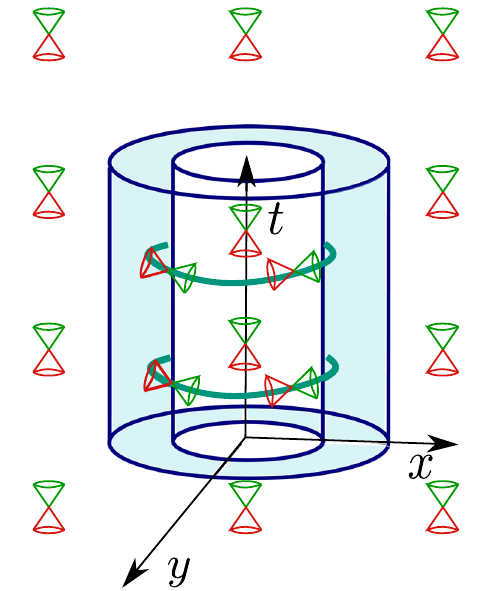
Fig. 6 We represent here the geometries described in the text. The different cases, corresponding essentially to the finite, the semi-infinite and the infinite cylinder display this same structure, with the difference relying on whether the cylinder is confined to lie within a compact interval [ t a , t b ] , a semi-infinite interval [ t C , ∞ ) or the whole real line ( −∞ , ∞ ) . The grey-shaded region lying within the inner and outer surfaces of the cylinder is the region where the angular coordinate φ becomes timelike, since the lightcones tilt enough for orbits of φ to be timelike curves. Outside the shaded region this abnormal behaviour of the ligthcones disappears and they are simply (or approximately as we have discussed in the text) flat spacetime lightcones. It must be noticed the difference between this higher dimensional case and the two-dimensional case discussed above: the existence of an additional dimension (the vertical t -axis in the figure) allows to regularize the lightcones within the core of the cylinder without needing to change the